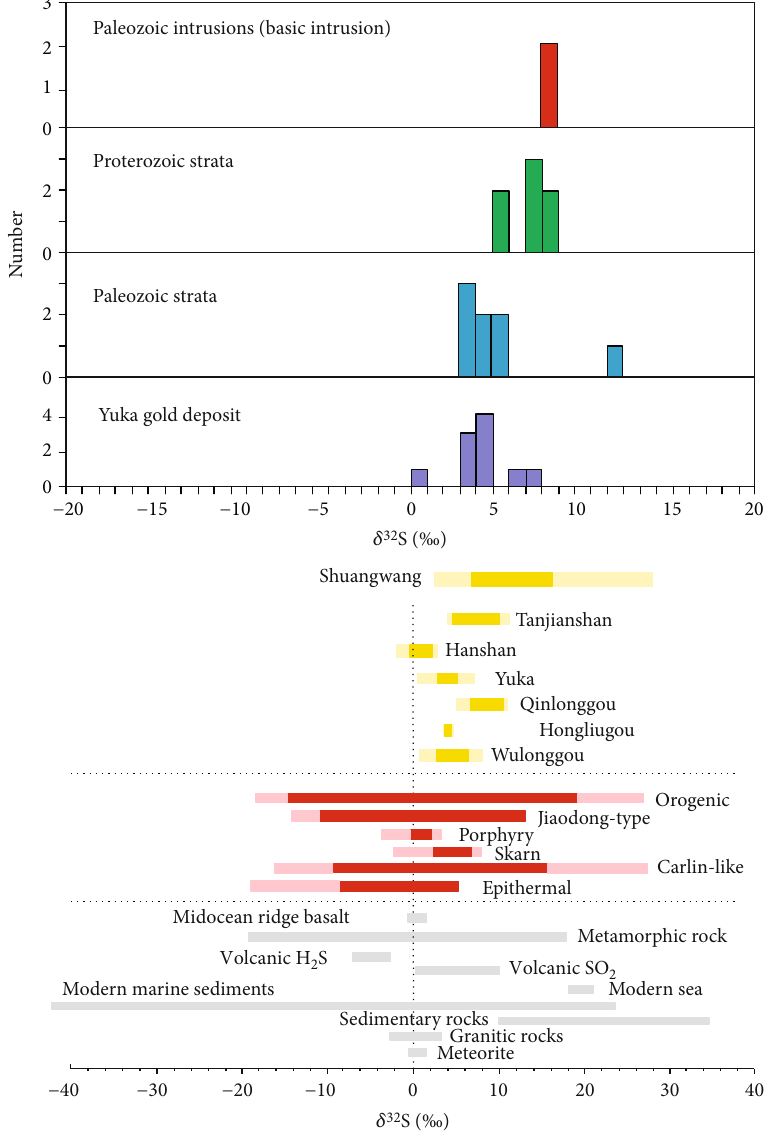
Figure 9: Histogram of sulfur (S) isotopic compositions of sul fi des from the Yuka gold deposit and related lithologies. δ 34 S values of Paleozoic strata are quoted from Zhu et al. [75]; δ 34 S values of Paleozoic intrusions are quoted from Guo and Chen [76]; δ 34 S values of Proterozoic strata are quoted from Zhang [74]. Other δ 34 S values are quoted from Deng and Wang